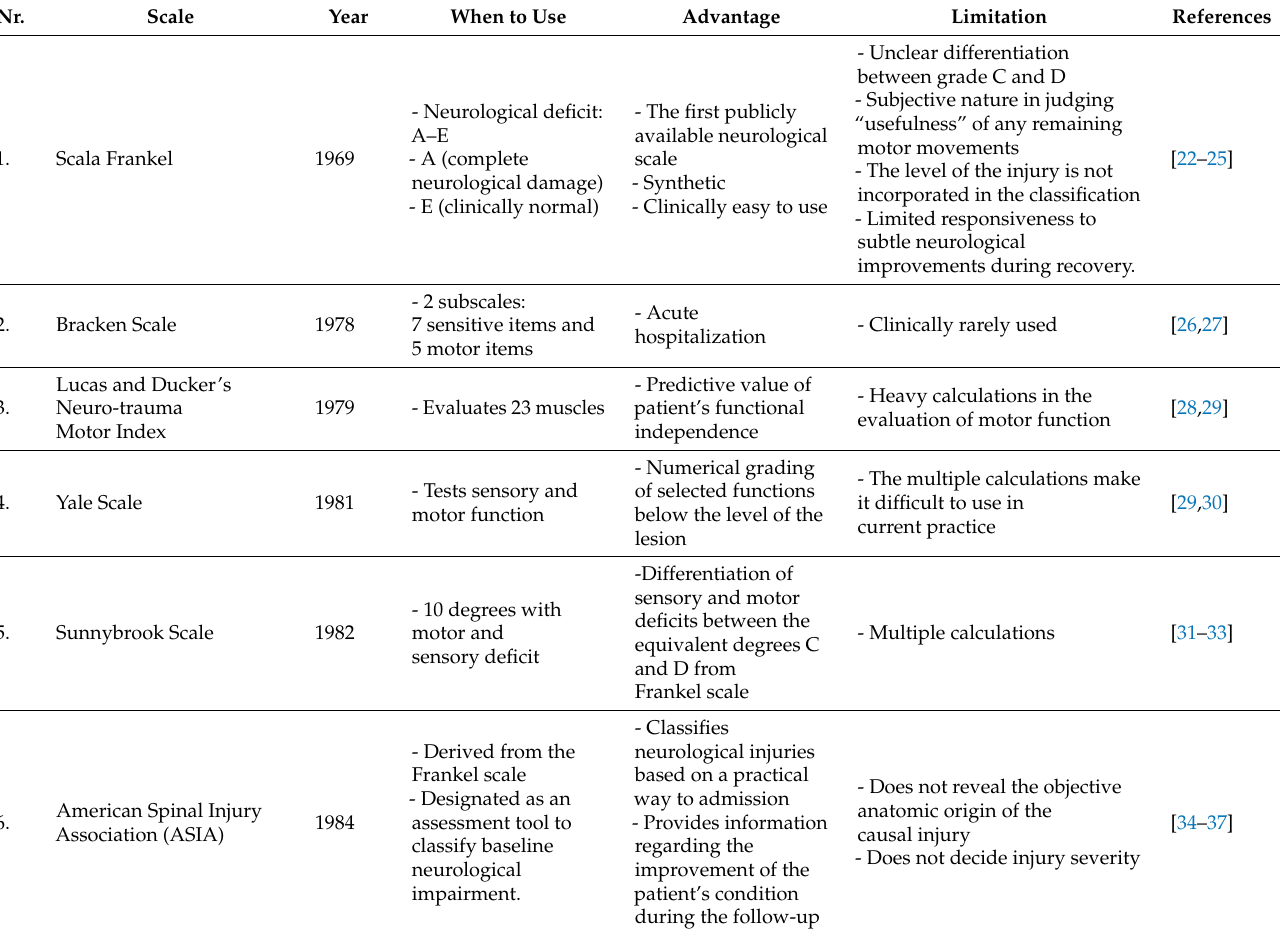
Table 1 is the neurological deficit assessment scales. Table 1. Neurological deficit assessment